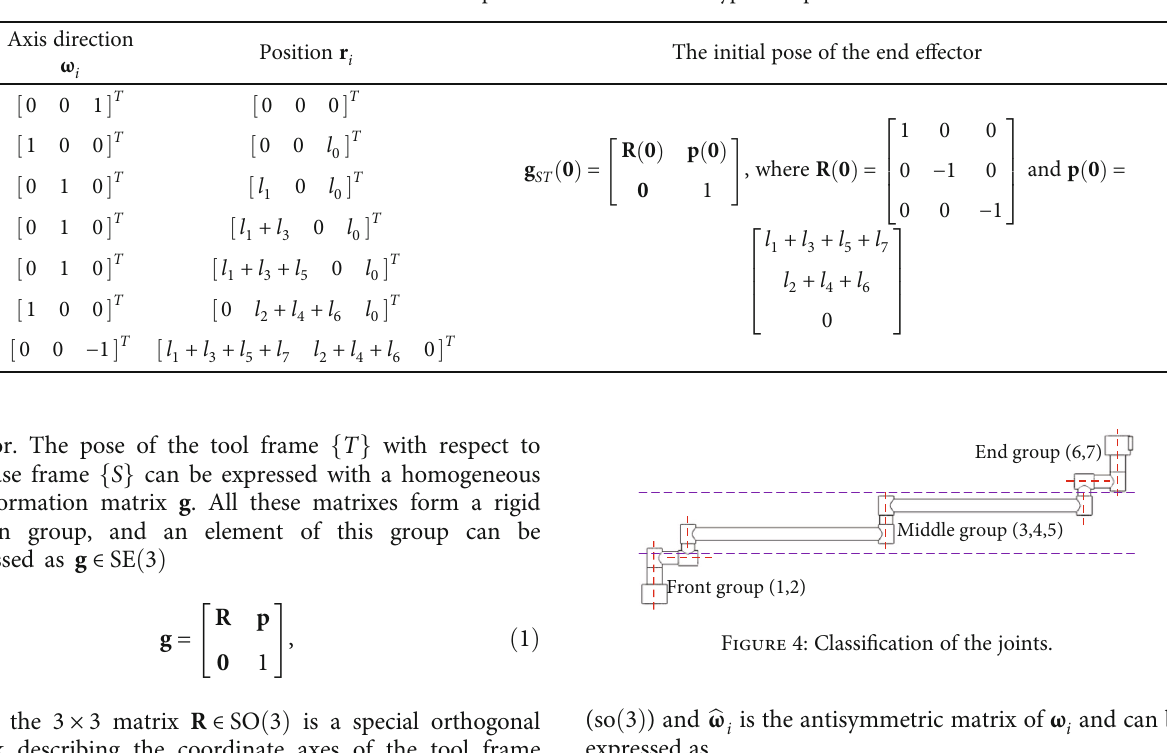
Table 1: The kinematics parameters of an SSRMS-type manipulator.